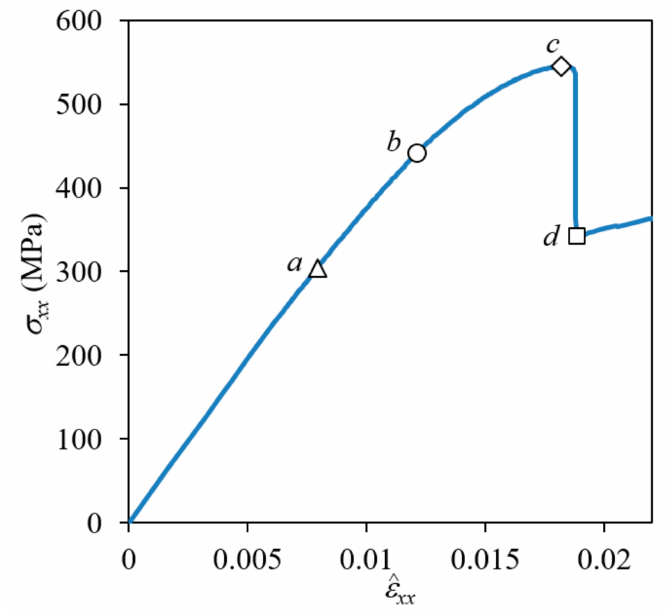
Figure 11. Nominal stress-strain curve for in-phase plain weave unit cell. (Markers a – d match to the fracture states in Figure